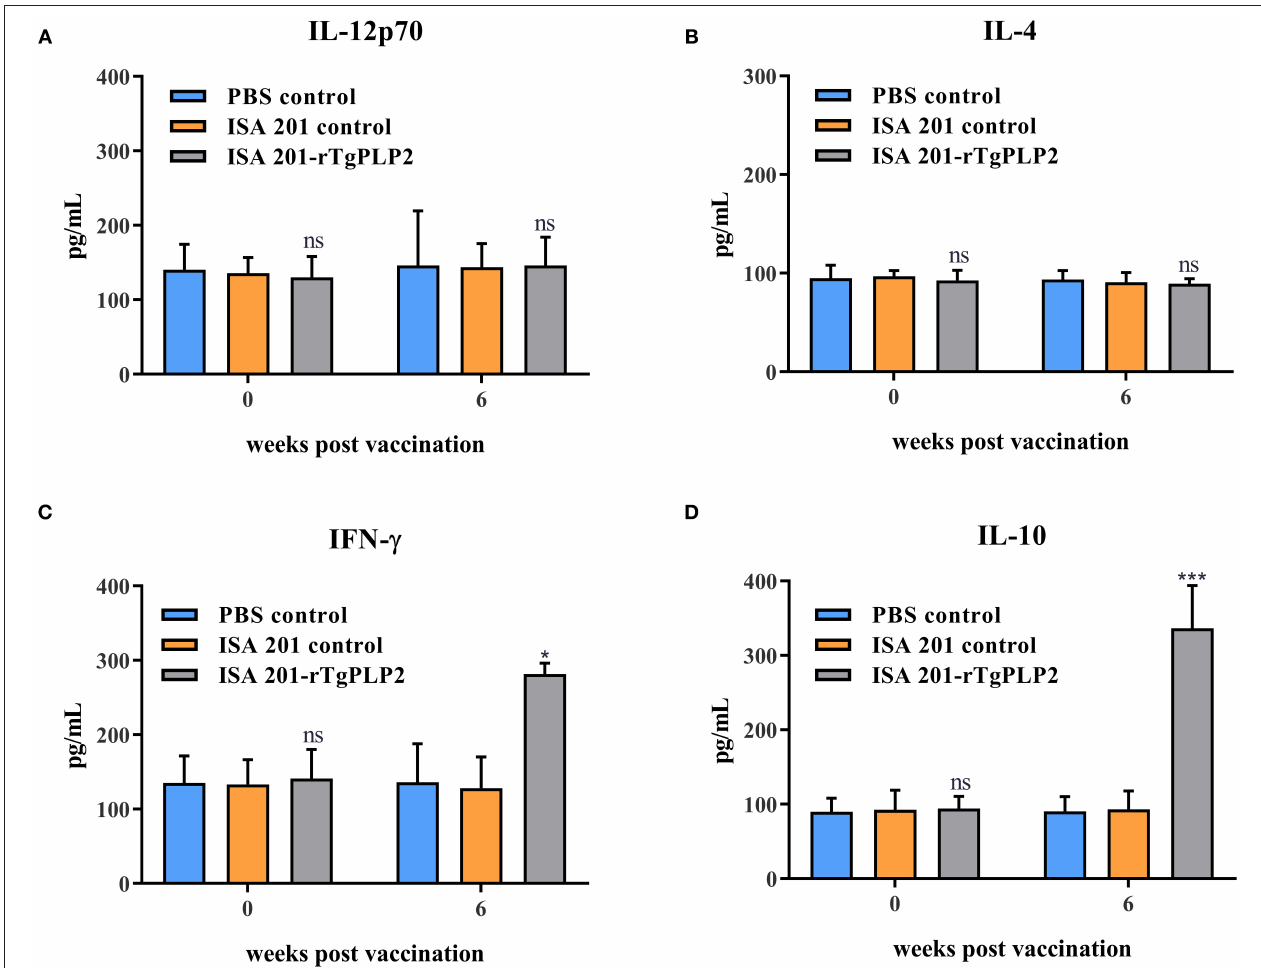
FIGURE 6 | Cytokines IL-12p70 (A) , IL-4 (B) , IFN- γ (C) , and IL-10 (D) levels of mice vaccinated with rTgPLP2 at various times Post-vaccination. Data were expressed as mean ± SEM for 10 mice per group. * p < 0.05, *** p < 0.001 and ns (Non-significant) vs. PBS or ISA 201 groups.